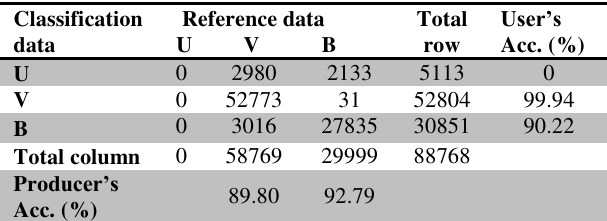
Table 6. Confusion matrix of labelled point based on NDFI G-NIR in Site II